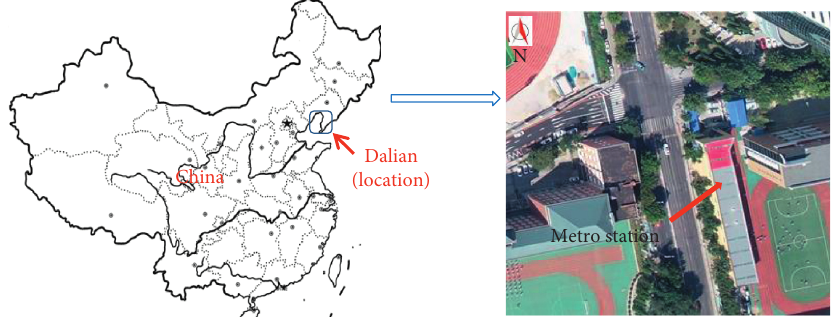
Figure 1: The location of the metro station.